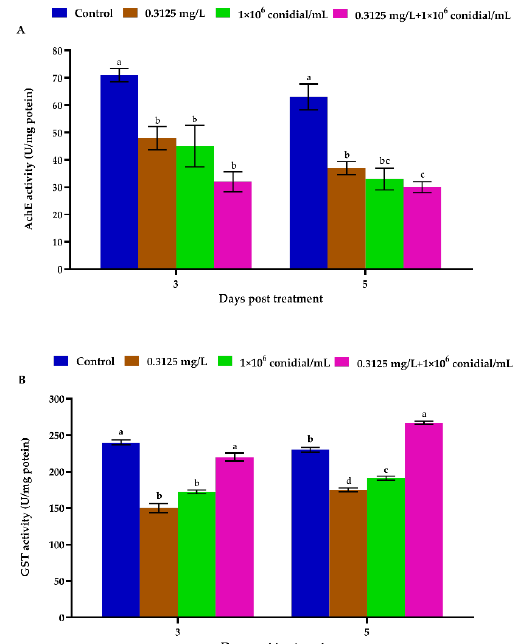
Figure 4. Acetylcholinesterase (AChE) and glutathione S-transferase (GST) activity ( N = 9) of M. usitatus in response to single or joint treatments of B. bassiana and emamectin benzoate, 3 and 5 days of treatment. The activity of acetylcholinesterase (AChE) ( A ); activity of glutathione S-transferase (GST) ( B ). Error bars indicate standard error of means based on three replicates. Bars with different letters indicate significant differences between treatments at various periods of time (Tukey’s test at 5% level of significance).